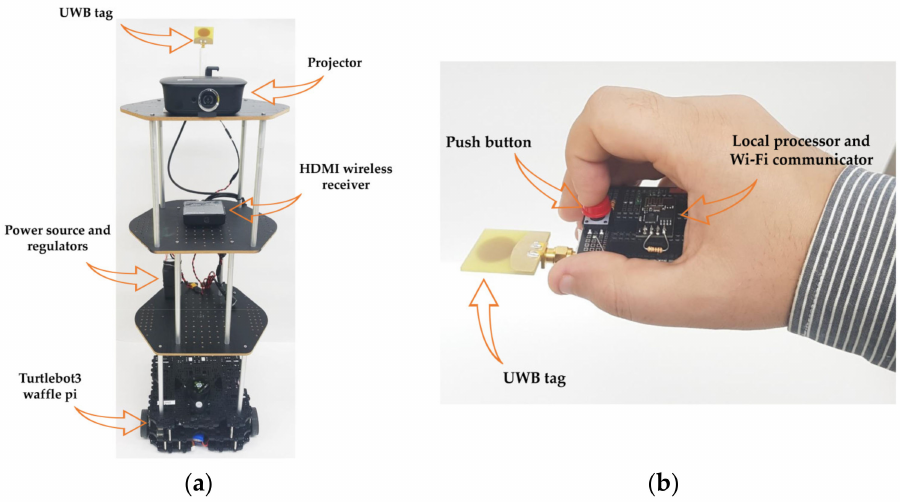
Figure 1. Ultra-wideband (UWB) wireless sensor network installation configuration.